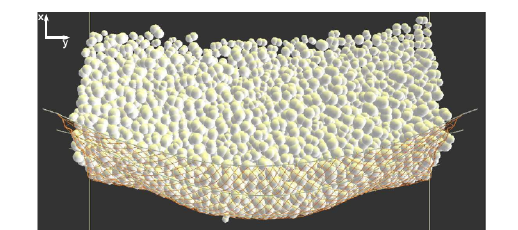
Figure 3. Snapshots of the granular flow impact on the flexible barrier [5]